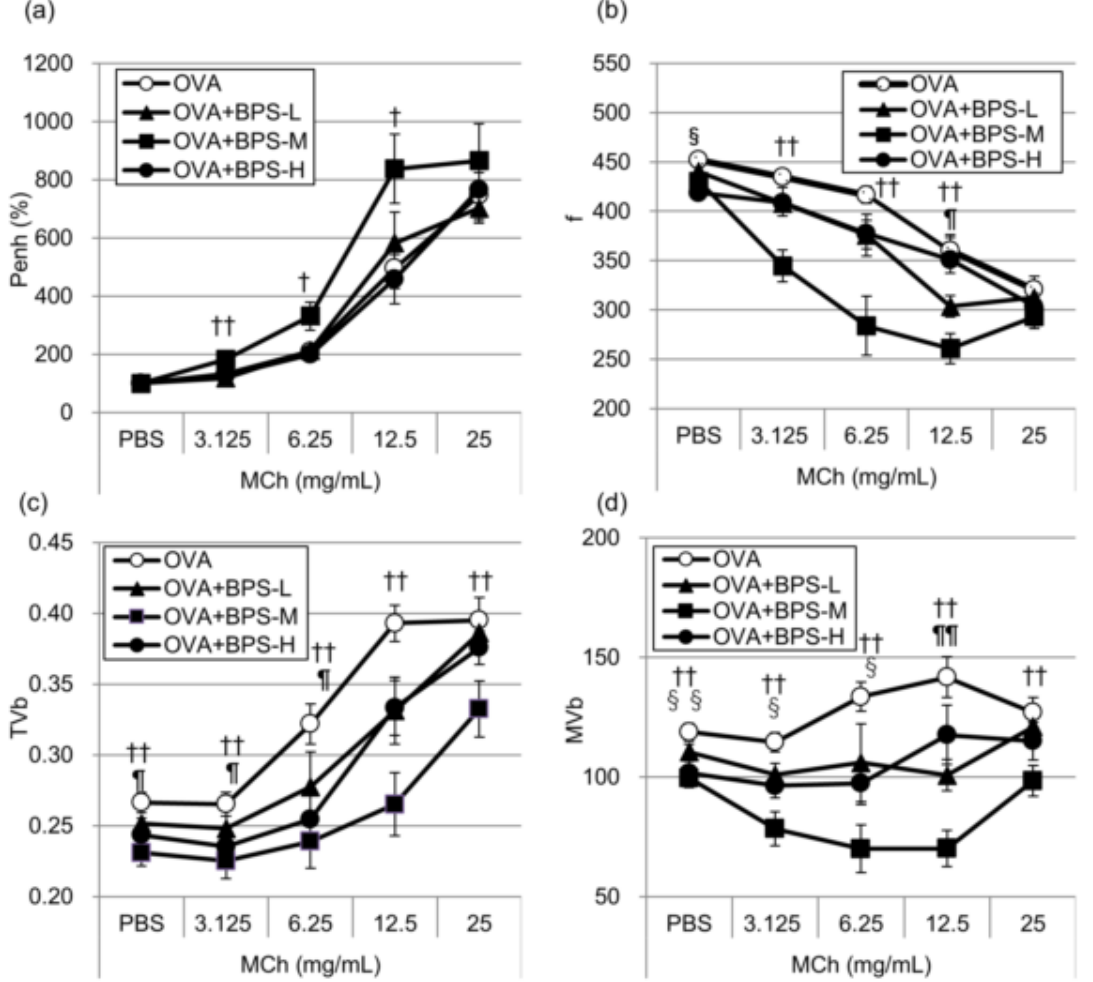
Figure 4. Changes in airway responsiveness in OVA-sensitized mice. Airway responsiveness to methacholine chloride 24 h after the final OVA intratracheal administration was measured using whole-body plethysmography. ( a ) Enhanced pause values. ( b ) Respiratory rate (f). ( c ) Tidal volume. ( d ) Minute volume. Data are expressed as mean ± SE for 5–6 animals per group. ¶ p < 0.05, OVA+BPS+L group vs. OVA group; ¶¶ p < 0.05, OVA+BPS+L group vs. OVA group; † p < 0.05, OVA+BPS+M group vs. OVA group; †† p < 0.01, OVA+BPS+M group vs. OVA group; § p < 0.05 OVA+BPS+H group vs. OVA group; §§ p < 0.01 OVA+BPS+H group vs. OVA group. BPS, bisphenol S; OVA, ovalbumin; SE, standard error.